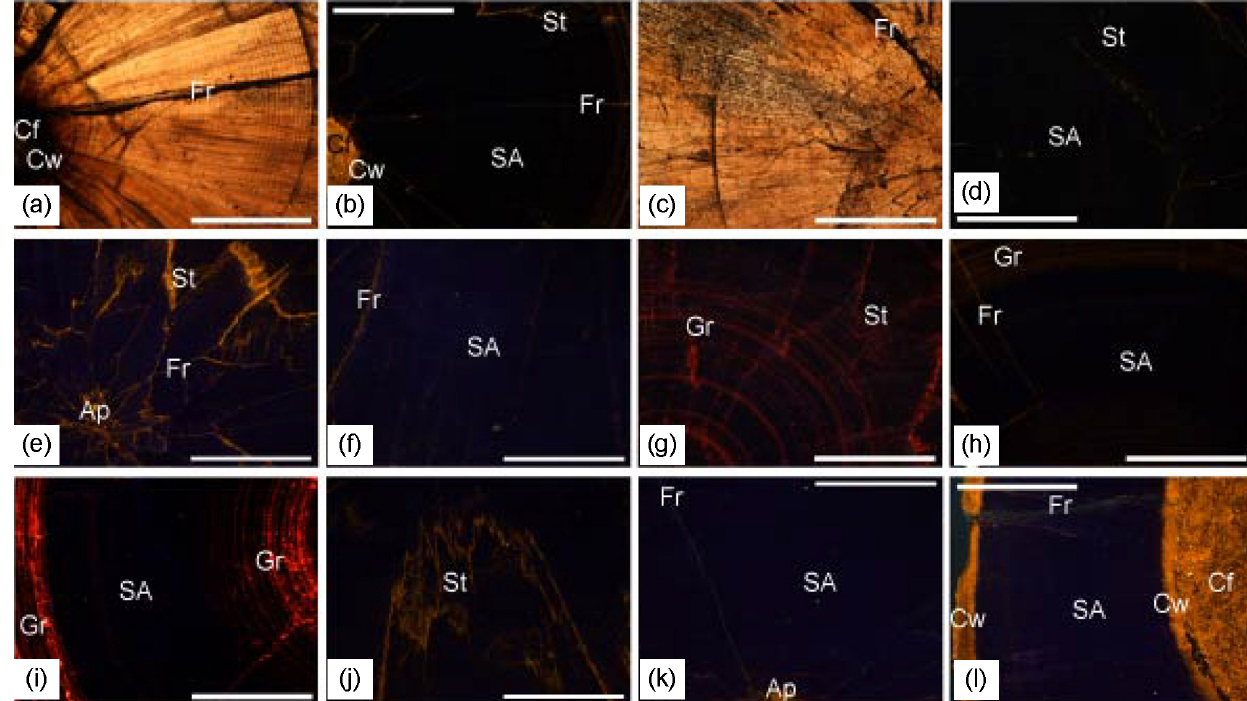
Figure 4. Thick sections photomicrographs of some of the belemnites sampled for stable isotope analysis from the Upper Sinemurian and Pliensbachian of the Rodiles section. The unaltered by diagenesis non-luminescent sampling areas (SA), where the samples have been collected, are indicated. (a) and (b) sample ER 351, Late Sinemurian Raricostatum Chronozone, Aplanatum Subchronozone. (a) : optical transmitted light microscope, showing the carbonate deposit filling the alveolous (Cf), the outer rostrum cavum wall (Cw) and fractures (Fr). (b) : cathodoluminescence microscope photomicrograph, showing luminescence in the carbonate deposit filling the alveolous (Cf), in the outer rostrum cavum wall (Cw) and in the fractures (Fr). SA represents the unaltered sampling area. (c) and (d) : sample ER 337, Early Pliensbachian Jamesoni Chronozone, Taylori-Polymorphus Subchronozones. (c) : optical transmitted light microscope, showing fractures (Fr). (d) : cathodoluminescence microscope photomicrograph, showing luminescence in stylolites (St). SA is the unaltered sampling area. (e) and (f) : Sample ER 589a Early Pliensbachian Margaritatus Chronozone, Subnodosus Subchronozone. (e) : cathodoluminescence micro- scope, showing luminescence in the apical line (Ap), fractures (Fr) and stylolites (St). This area of the section was not suitable for sampling. (f) : another field of the same sample as (h) showing scarce fractures (Fr) and the unaltered non-luminescent sampled area (SA). (g) and (h) : Sample ER 549a, Late Pliensbachian Margaritatus Chronozone, Stokesi Subchronozone. (g) : cathodoluminescence microscope showing luminescent growth rings (Gr) and stylolites (St). Area not suitable for sampling. (h) : cathodoluminescence microscope photomicrograph, of the same sample as (g) , showing luminescent growth rings (Gr) and fractures (Fr), with unaltered sampling area (SA). (i) : sample ER 555 Late Pliensbachian Margaritatus Chronozone, Stokesi Subchronozone. Cathodoluminescence microscope photomicrograph showing luminescent growth rings (Gr) and the unaltered sampling area (SA). (j) and (k) : sample ER 623 Late Pliensbachian Spinatum Chronozone, Apyrenum Subchronozone. (j) : cathodoluminescence microscope photomicrograph showing luminescent stylolites (St). (k) : another field of the same sample as (j) showing luminescence in the apical line (Ap) and fractures (Fr) as well as the non-luminescent unaltered sampling area (SA). (l) : sample ER 597, Late Pliensbachian Margaritatus Chronozone, Gibbosus Subchronozone. Cathodoluminescence microscope photomicro- graph showing luminescent carbonate deposit filling the alveolous (Cf), the outer and inner rostrum cavum wall (Cw), the fractures (Fr) and the non-luminescent sampling area (SA). Scale in bar for all the photomicrographs: